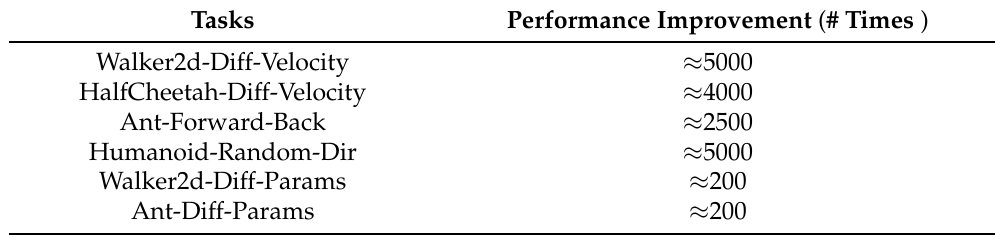
Table 3. Quantitative studies the proposed meta reinforcement learning algorithm.